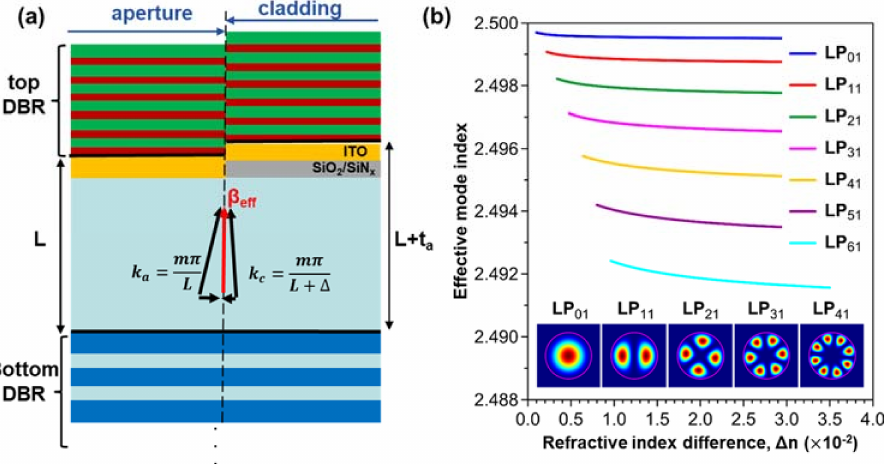
Figure 4. ( a ) Schematic illustration of anti-guiding effect due to the dielectric aperture ( b ) Calculated mode effective indices of LP mn modes of a 6- µ m-diameter nitride VCSEL with varying index differ- ence ( ∆ n) between aperture and cladding region 2. The carrier aperture dimension in ( b ) follows the reference [24] (Data from